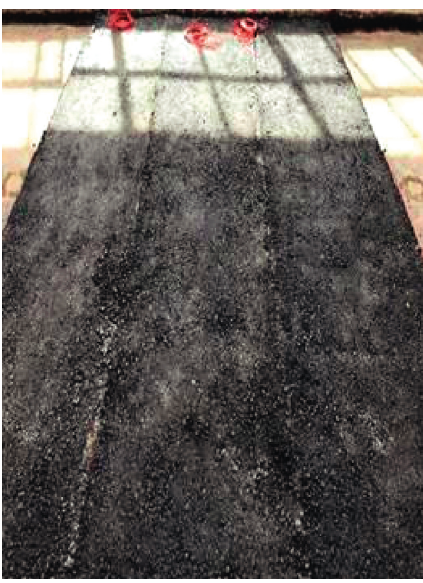
Figure 8: Field map of full-scale indoor test road (from left to right in the field map: REOB-rejuvenated asphalt concrete, RA5-re- juvenated asphalt concrete, and base asphalt